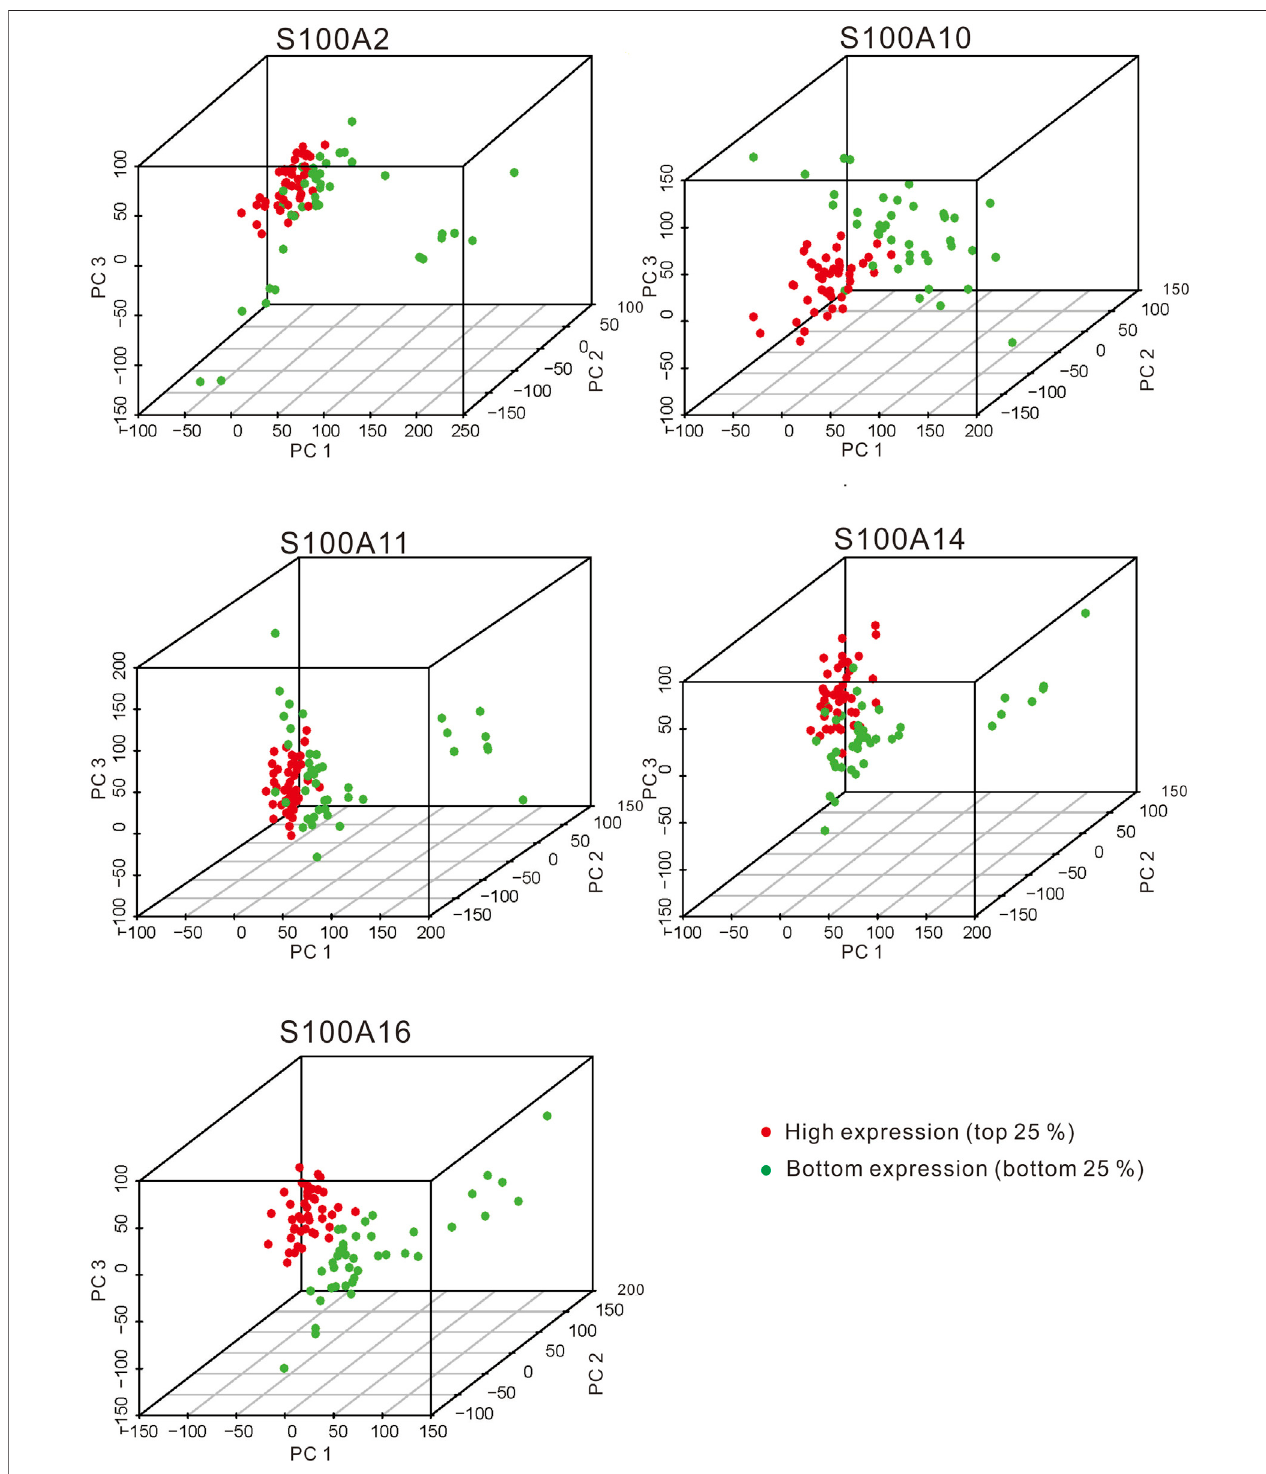
FIGURE 12 | The PCA plots showed the genes in samples with signi fi cant S100 gene high expression (top 25%) and low expression (bottom 25%) samples (calculated datafrom TCGA-PAAD, n (cid:1) 178). Thered dotand green dotindicate thesmapleswiththehigh expression ofthesigni fi cantS100genes (top25percentile) and the low expression (bottom 25 percentile) samples,